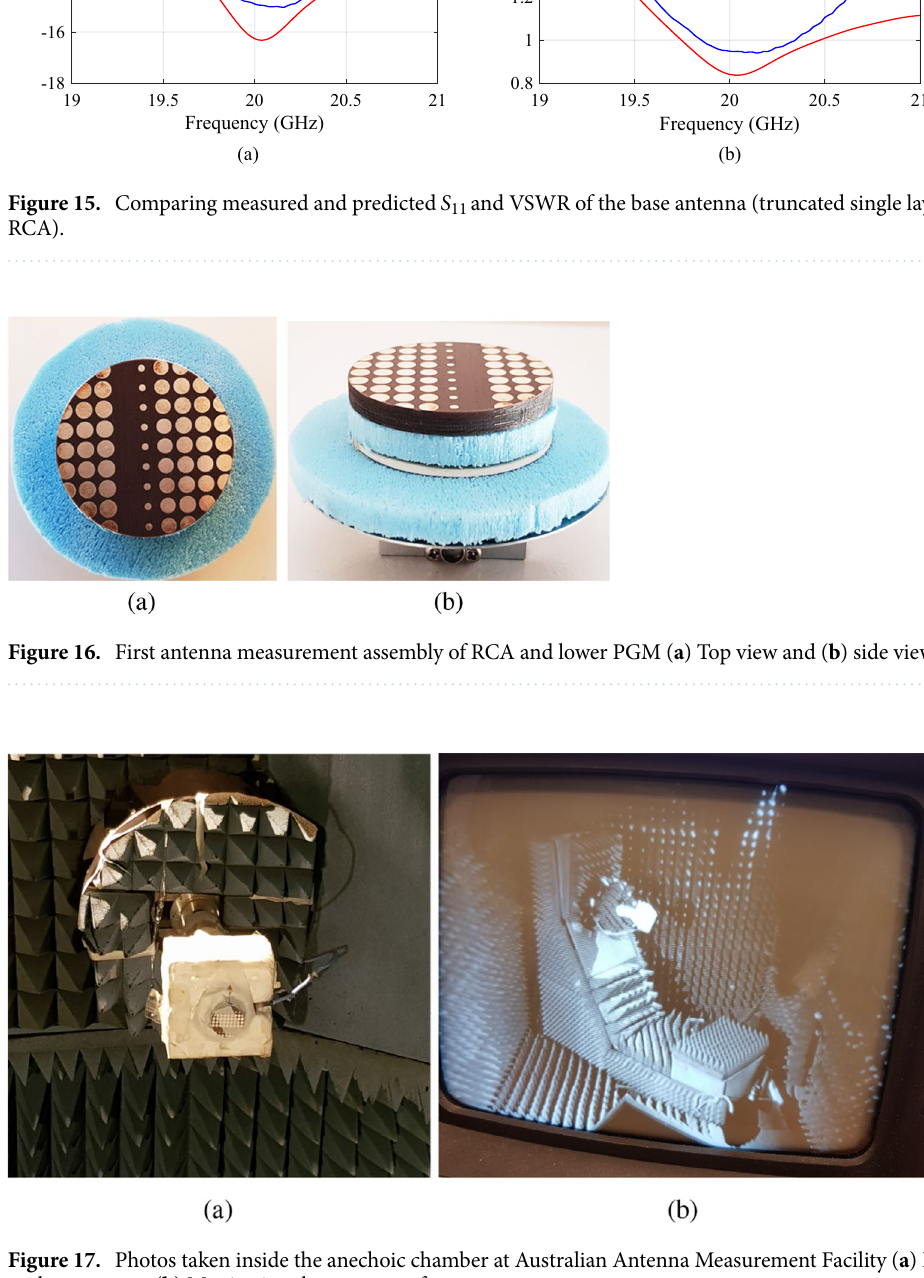
Figure 17. Photos taken inside the anechoic chamber at Australian Antenna Measurement Facility ( a ) Device under test setup ( b ) Monitoring the progress of measurement on a computer